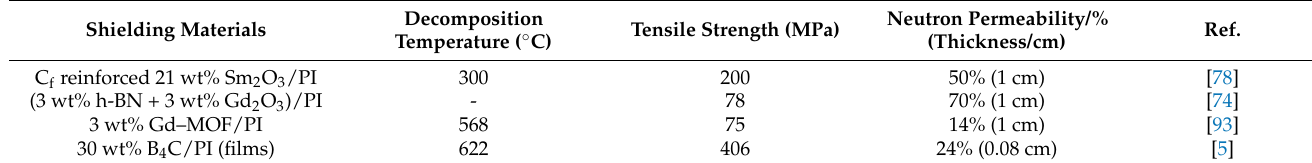
Figure 15. Interaction of neutrons and gamma rays in the multi-layer material [94]. Table 6. Performance comparison of PI-based neutron-shielding